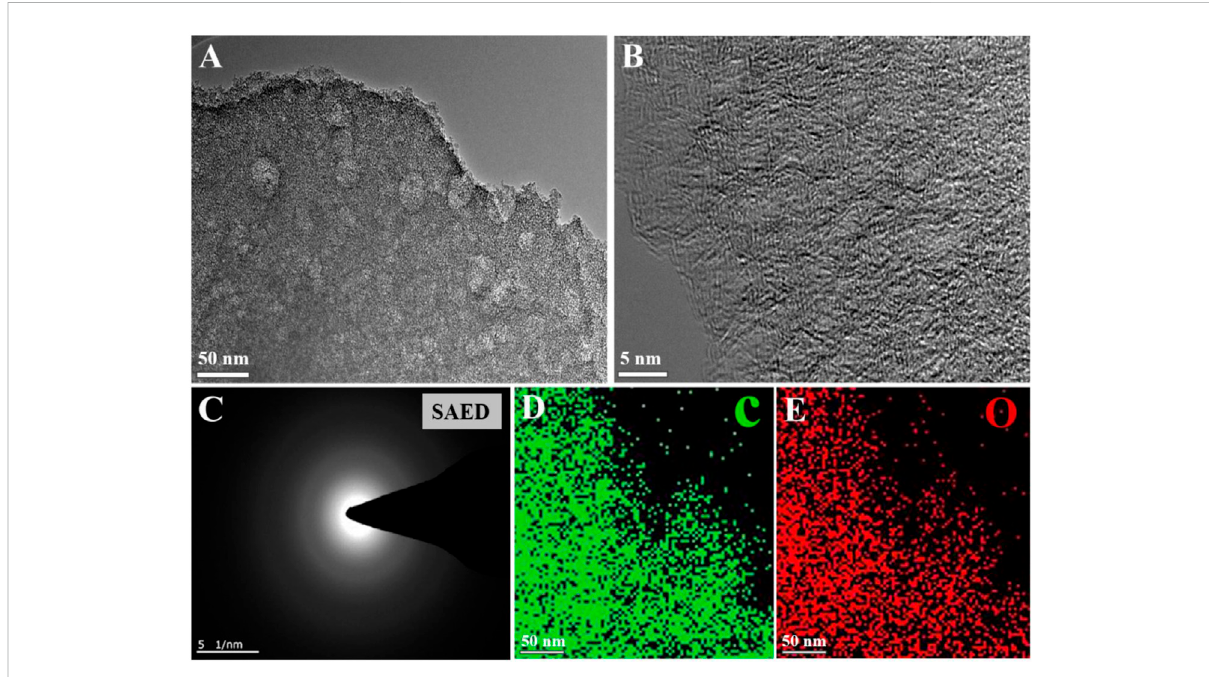
FIGURE 2 (A) TEMimageofAWC-K; (B) HR-TEMimageofAWC-K; (C) SAEDpatternofAWC-K; (D – E) theimagesofthedifferentAWC-Kelementsthatare